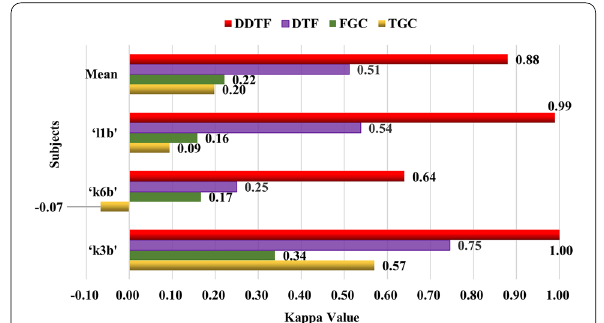
Fig. 16 Comparison of average classification rates with GC-based BFN methods on Dataset